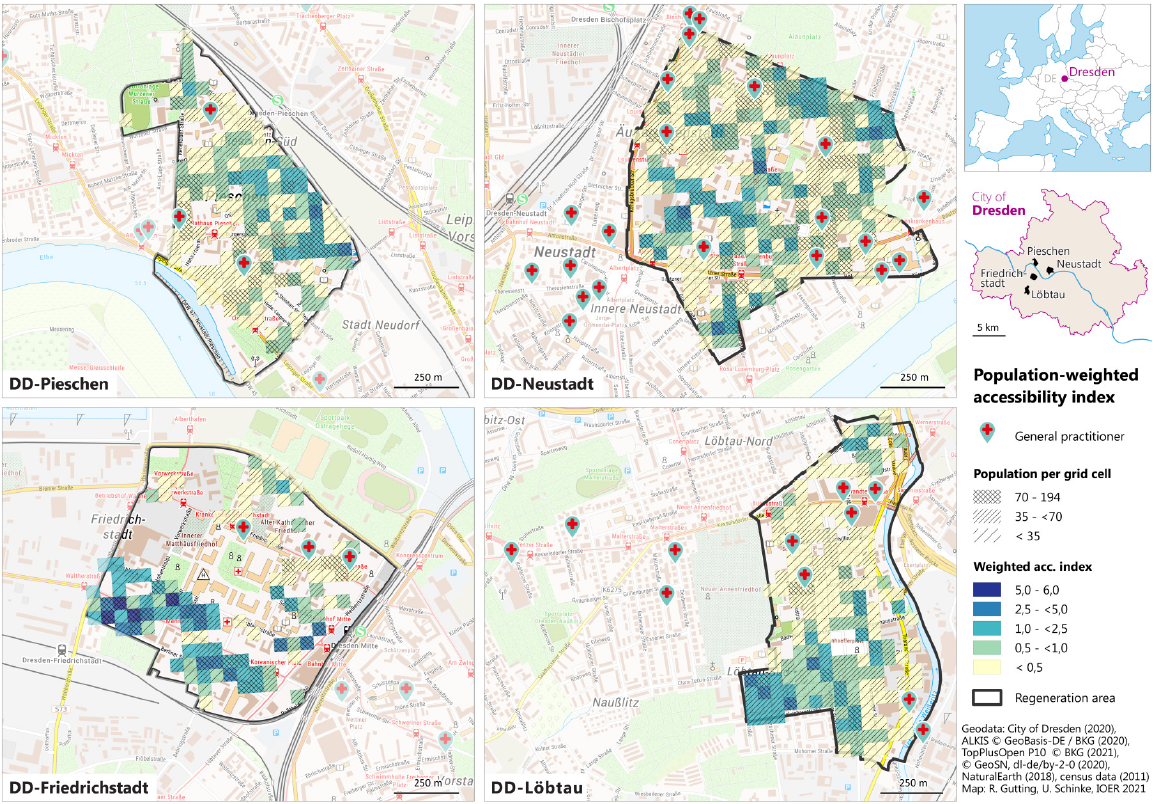
Figure 7. Grid cells showing population density and population‐weighted accessibility index regarding access to general